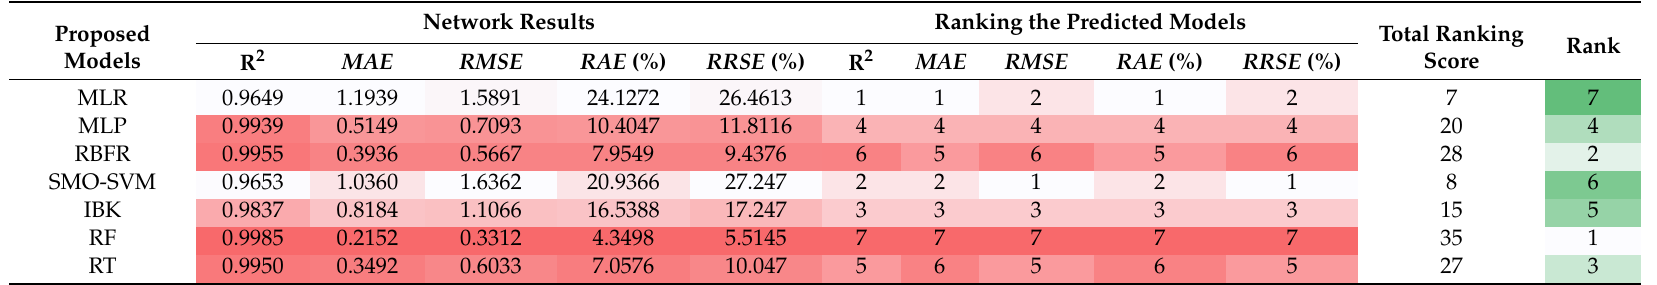
Table 4. Total ranking of the testing dataset in predicting the factor of